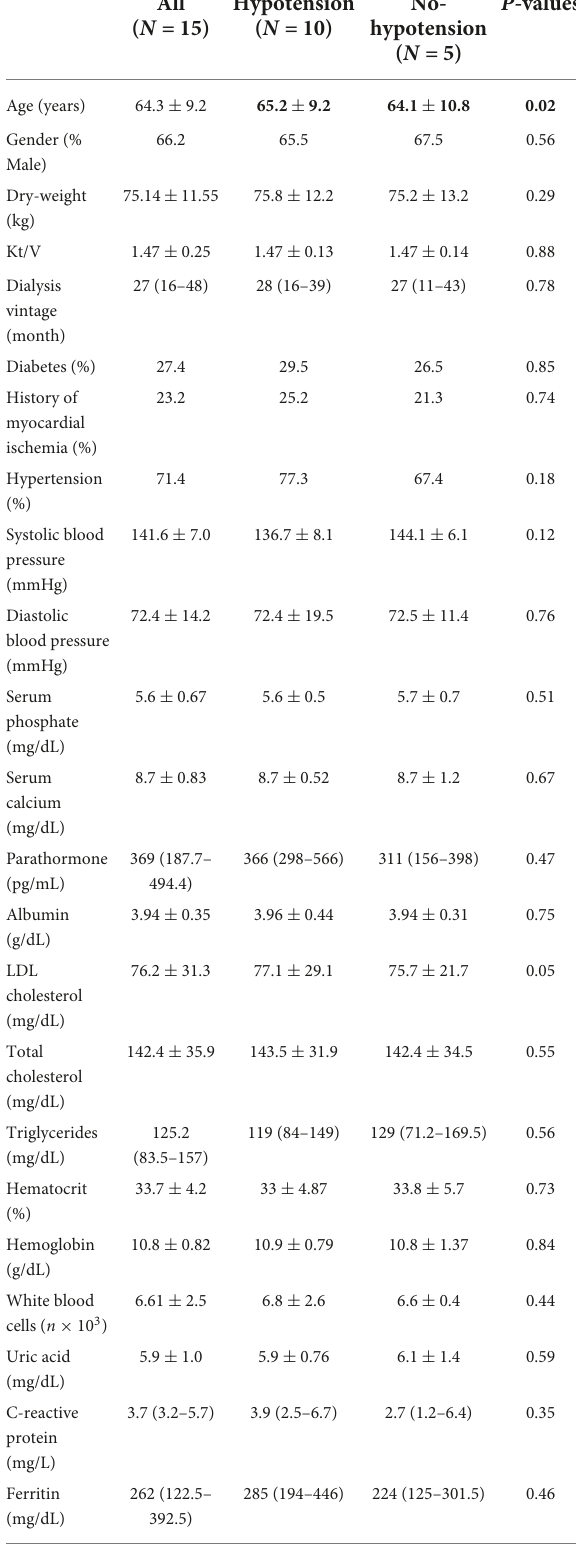
TABLE 1 Main clinical and laboratory characteristics of the population and differences between